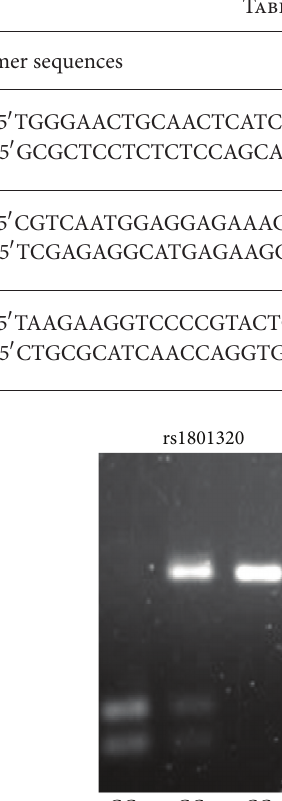
Table 3: Details of PCR-RFLP of the studied SNPs.